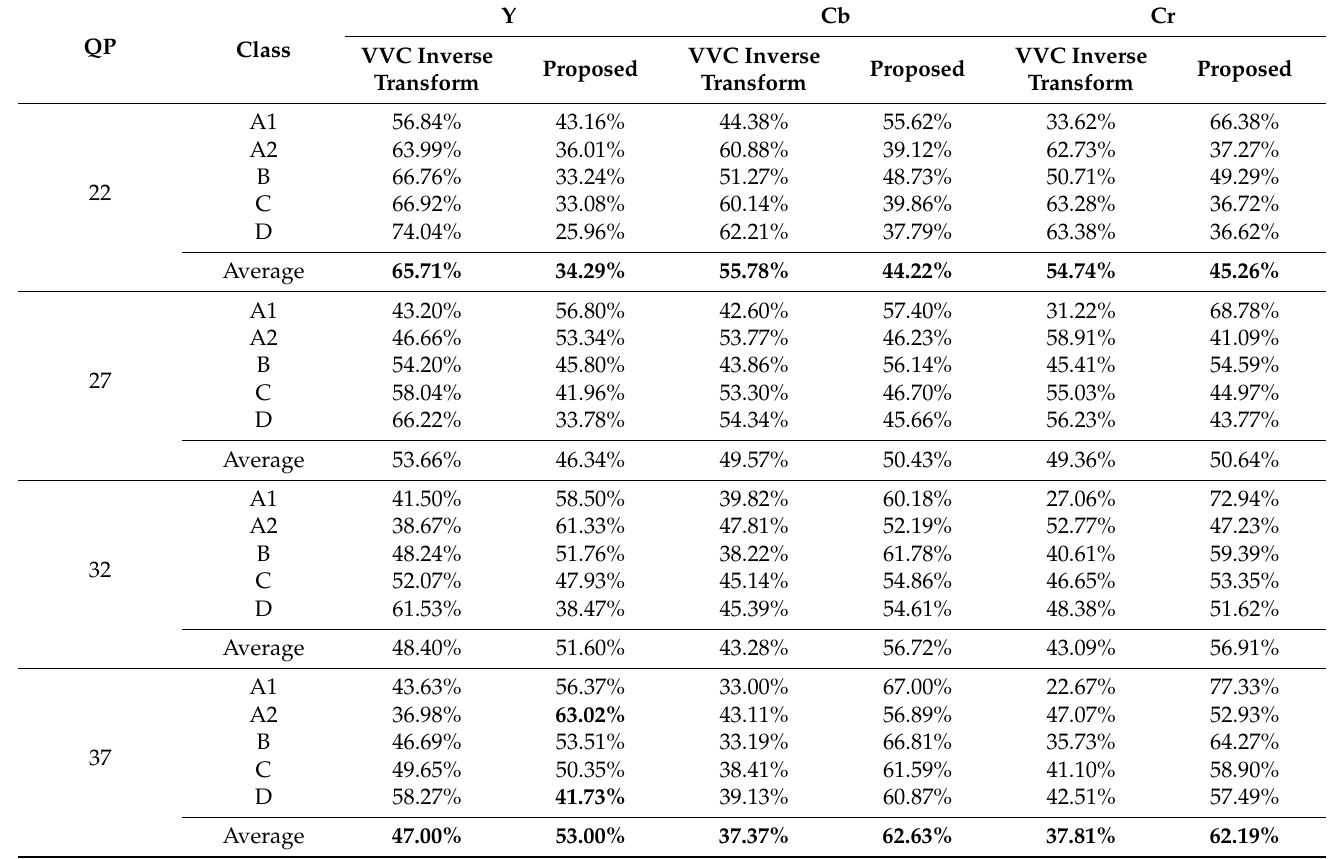
Table 9. Average selection ratios of VVC inverse transform and the proposed method for each QP for all test